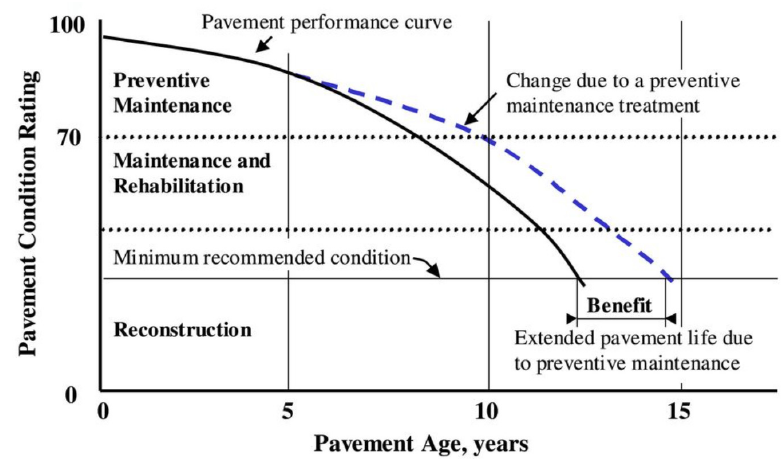
Figure 3. Expected effects of maintenance strategies on pavement condition.